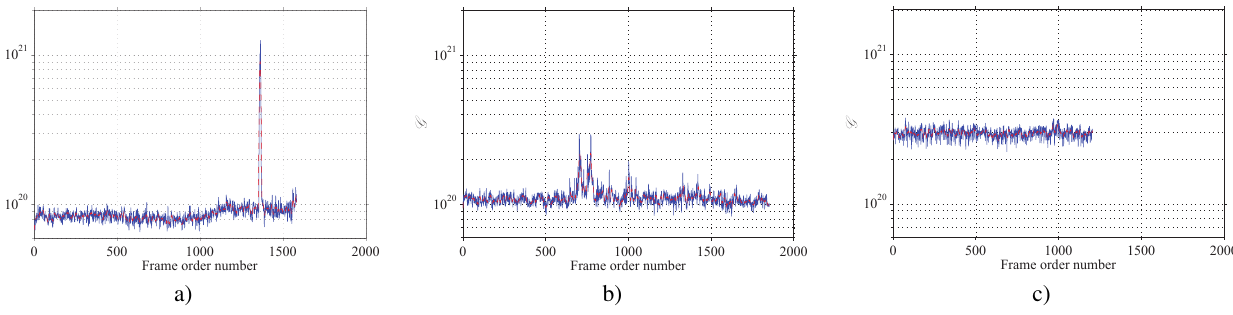
Fig. 9. Index G as obtained from Eq. (1) for (a) beads of 75–90µm; (b) 1000–1180µm; and (c) 500–600µm. Moving averaged index, G , is presented in red. Table 3. Velocities obtained through the image analysis procedure, IM Velocity, and visual analysis, VA Velocity. VA velocities are re- ported for the larger classes of diameters since experiments with smaller particles do not allow for accurate travel time